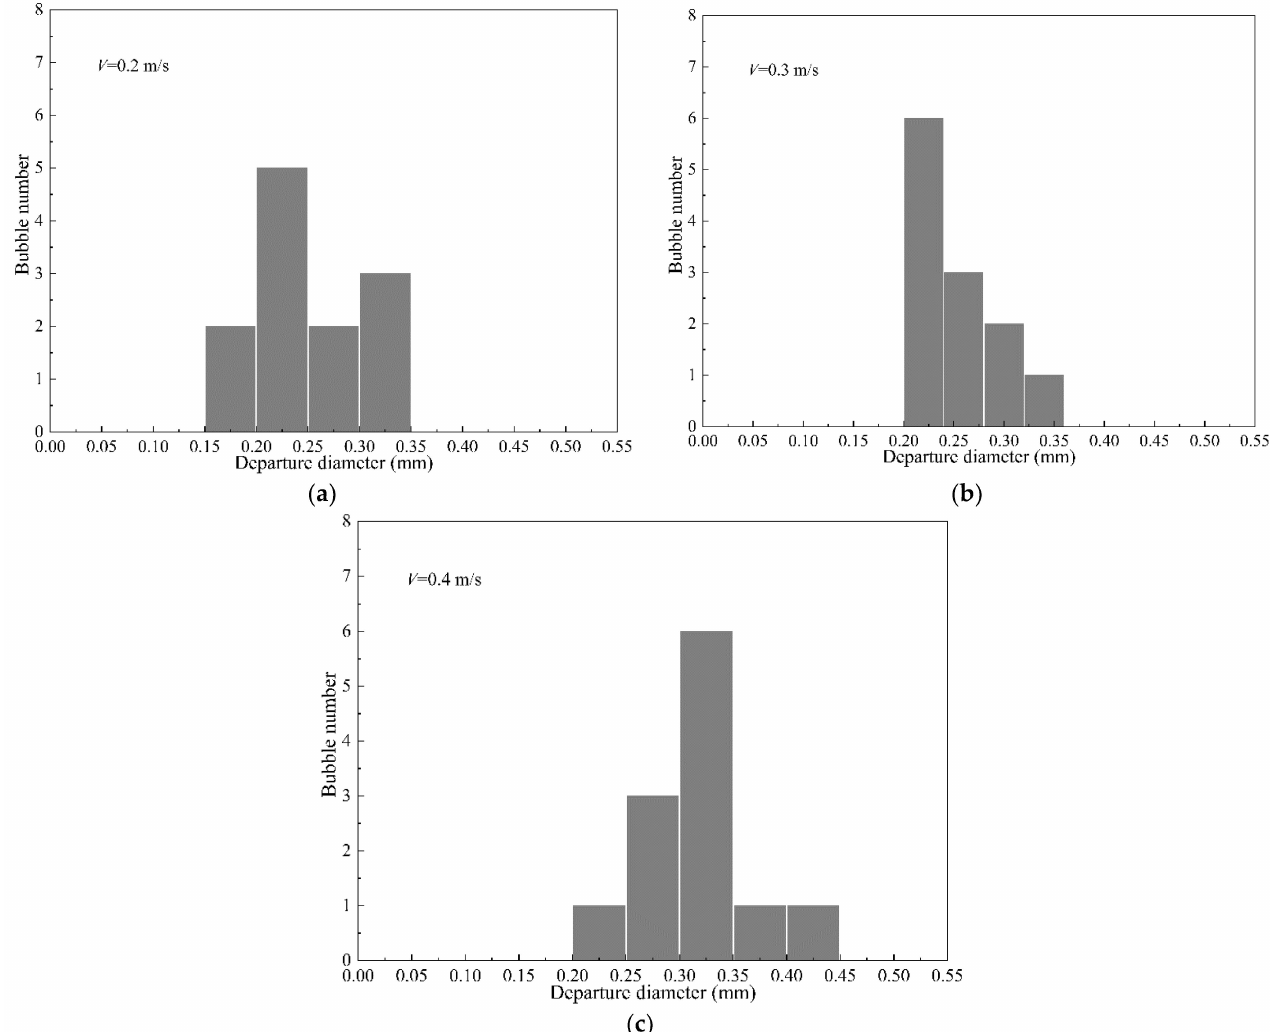
Figure 13. Bubble departure diameter at different inlet velocities, ( q = 0.3 MW/m 2 , ∆ T sub = 3 K): ( a ) bubble departure diameter at inlet velocity of 0.2 m/s; ( b ) bubble departure diameter at inlet velocity of 0.3 m/s; ( c ) bubble departure diameter at inlet velocity of 0.4